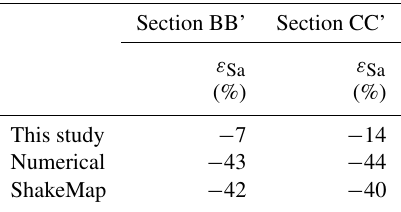
Table 5. Difference ε in percentage between Sa 0 . 3 determined by means of different methodologies and recorded values for the cen- tral Italy earthquake that occurred on 24 August